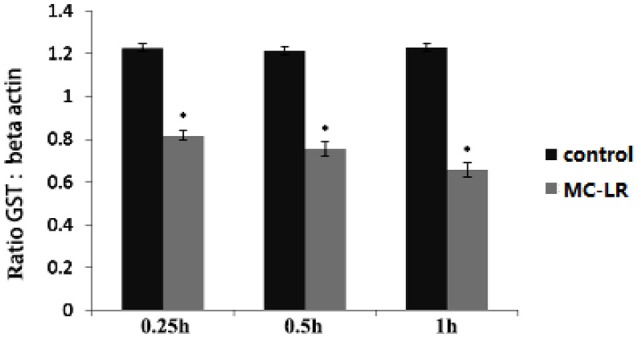
Relative mRNA expression of the GST gene in silver carp livers at 0.25, 0.5, and 1 h after exposure to MC-LR compared with the control fish. *Indicates a significant difference between treatment and control.